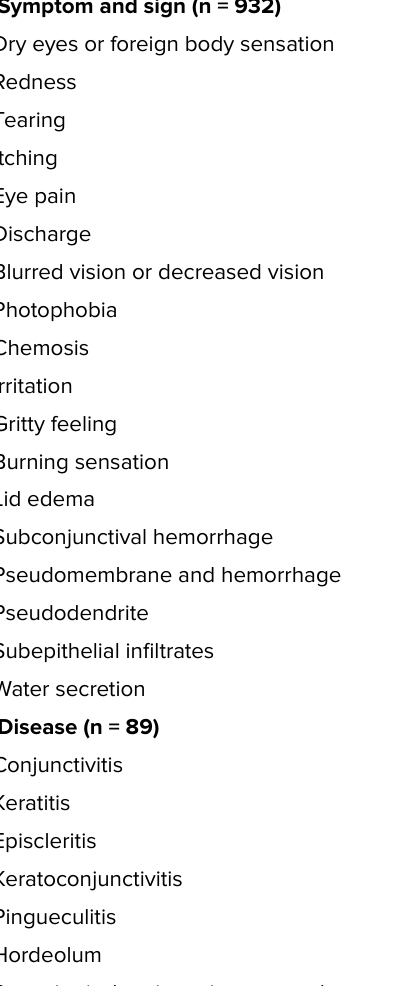
Table 2. Symptoms and diseases of ocular in COVID-19 infection included in the reviewed studies ( n = 1,021) Characteristics